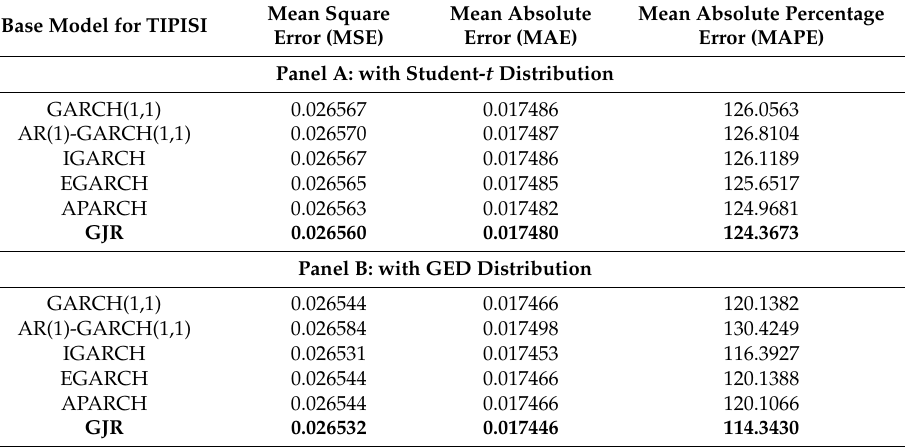
Table 5. Evaluation of one-day out-of-sample volatility forecasts comparison for the TIPISI. The table presents the loss functions values of the TIPISI. Panel A displays the loss functions values for one-day out-of-sample volatility forecasts of the TIPISI using Student- t distribution. Panel B displays the loss functions values for one-day out-of-sample volatility forecasts of the TIPISI using GED distribution. This table also presents the forecasting criteria: Mean Square Error (MSE), Mean Absolute Error (MAE), and Mean Absolute Percentage Error (MAPE). Lowest values for the statistics are denoted in bold face.